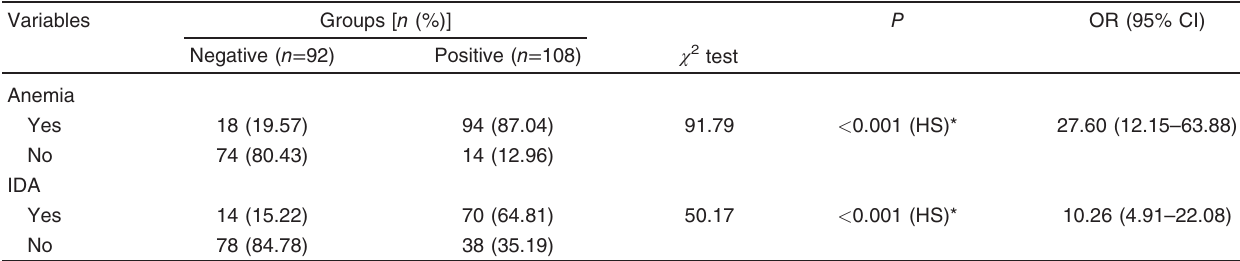
Table 4 Comparison between anemic and nonanemic cases in all study groups regarding presence of recurrent chest infection